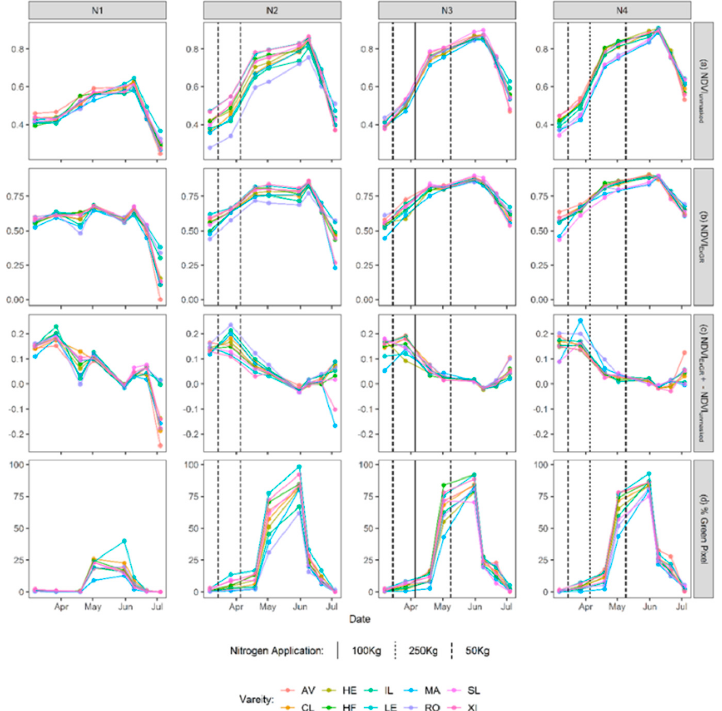
Figure 18. Temporal trends of ten wheat cultivars grown under four di ff erent nitrogen treatments for: ( a ) the standard unmasked mean NDVI; ( b ) mean NDVI derived from ExGR masked plots to remove the influence of background soil; ( c ) displaying temporal di ff erences between masked and unmasked NDVI results; ( d ) percentage green pixel as calculated from the ExGR masks. Nitrogen application dates and quantities for the N2, N3 and N4 treatments are presented by the vertical lines. All data represent the means of three